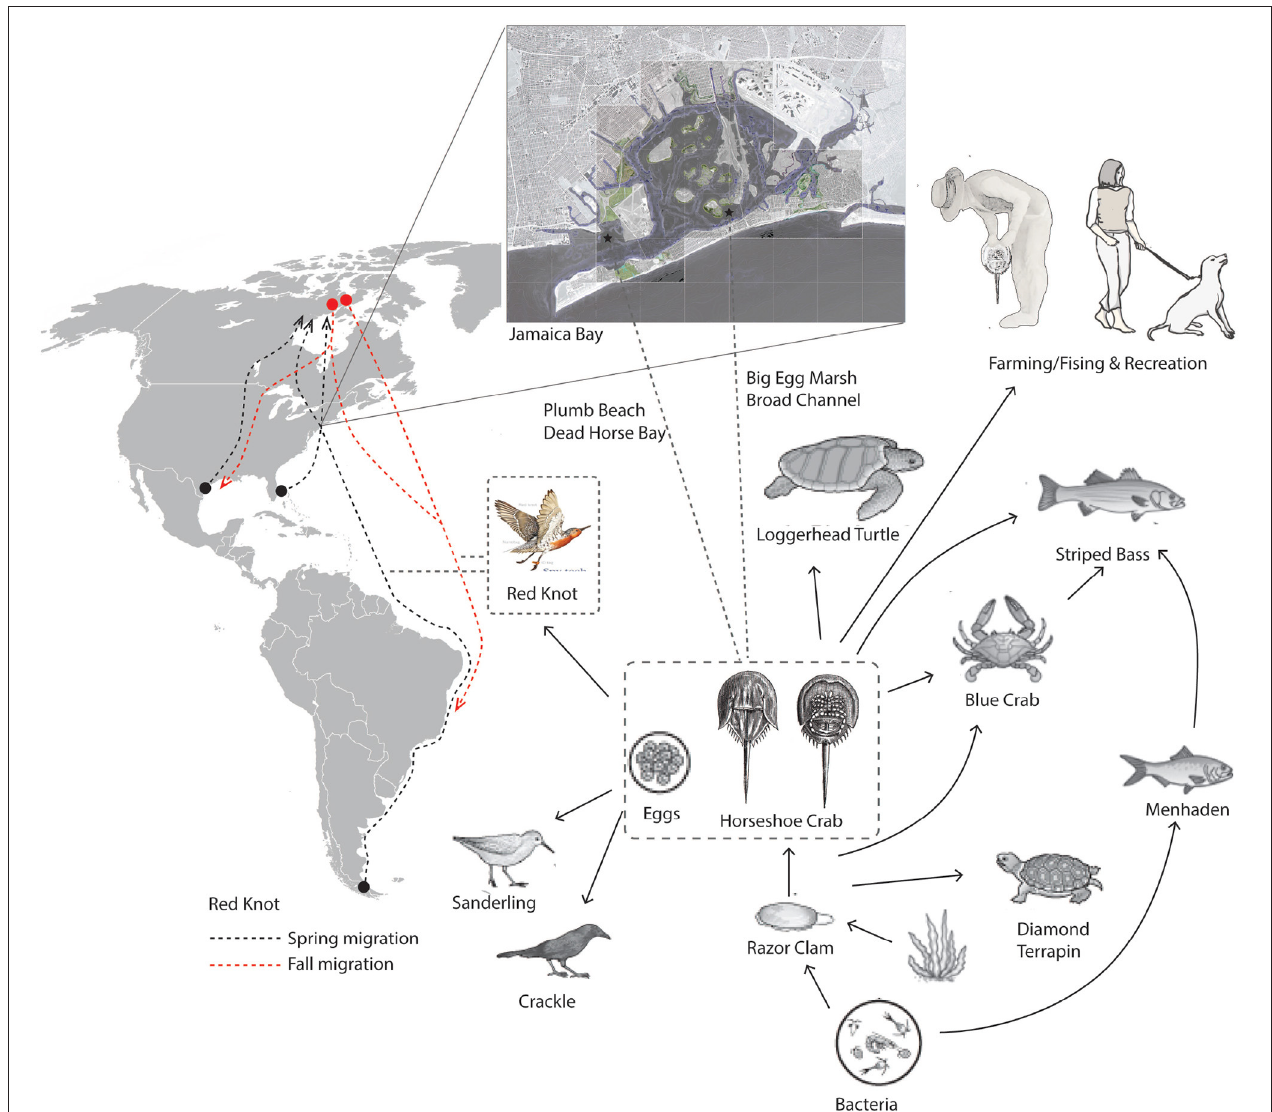
FIGURE 4 | The food web of Jamaica Bay has local, continental, and transcontinental linkages, and includes people and marine and terrestrial species, some of which are of conservation concern. Image by Alexander Felson/UED Lab and used with